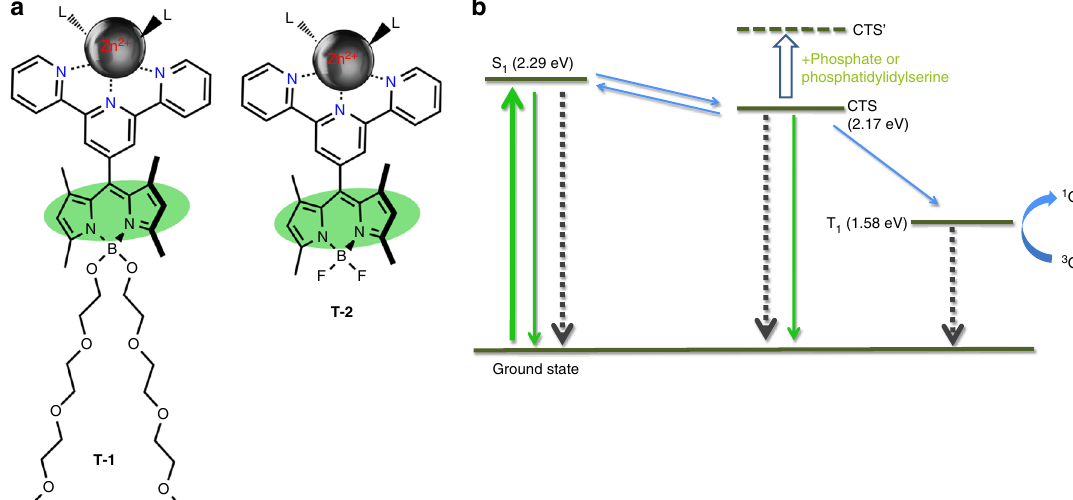
Fig. 2 The structures of the molecular automata T-1 and T-2 and the Jablonski diagram depicting processes involved. a L indicates solvent molecules as ligands, water, or acetonitrile. Bodipy and the terpyridyl planes are orthogonal to each other due to the presence of 1,7-dimethyl substitution of the Bodipy chromophore. Double mTEG (methoxytriethyleneglycol) substitution at the boron center enhances water solubility. b Thicker green arrow is absorption, the other green arrows indicate radiative relaxations. Black-dashed arrows are non-radiative relaxation processes. Blue arrows indicate transitions between various excited states. CTS to T 1 transition is particularly enhanced because of the orthogonal geometry of the terpyridyl-Bodipy diad. Energy levels were experimentally estimated using the spectral data (S 1 , CTS) in analogy to previous literature 22 , or based on the phosphorescence data 32 for similar